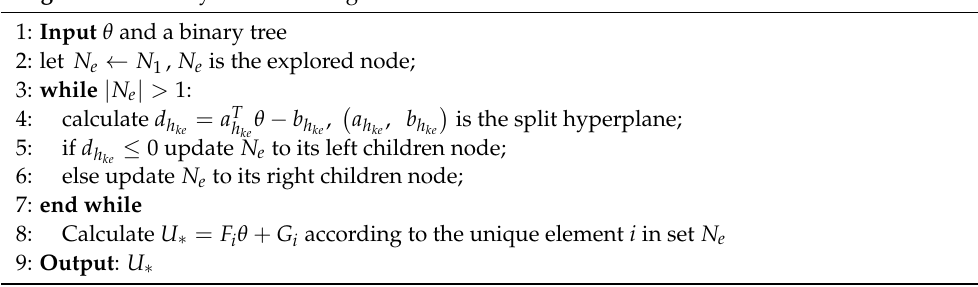
Algorithm 2 Binary tree search